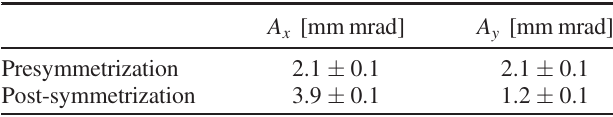
TABLE V. Measured horizontal and vertical acceptance of the presymmetrization and post-symmetrization sextupole